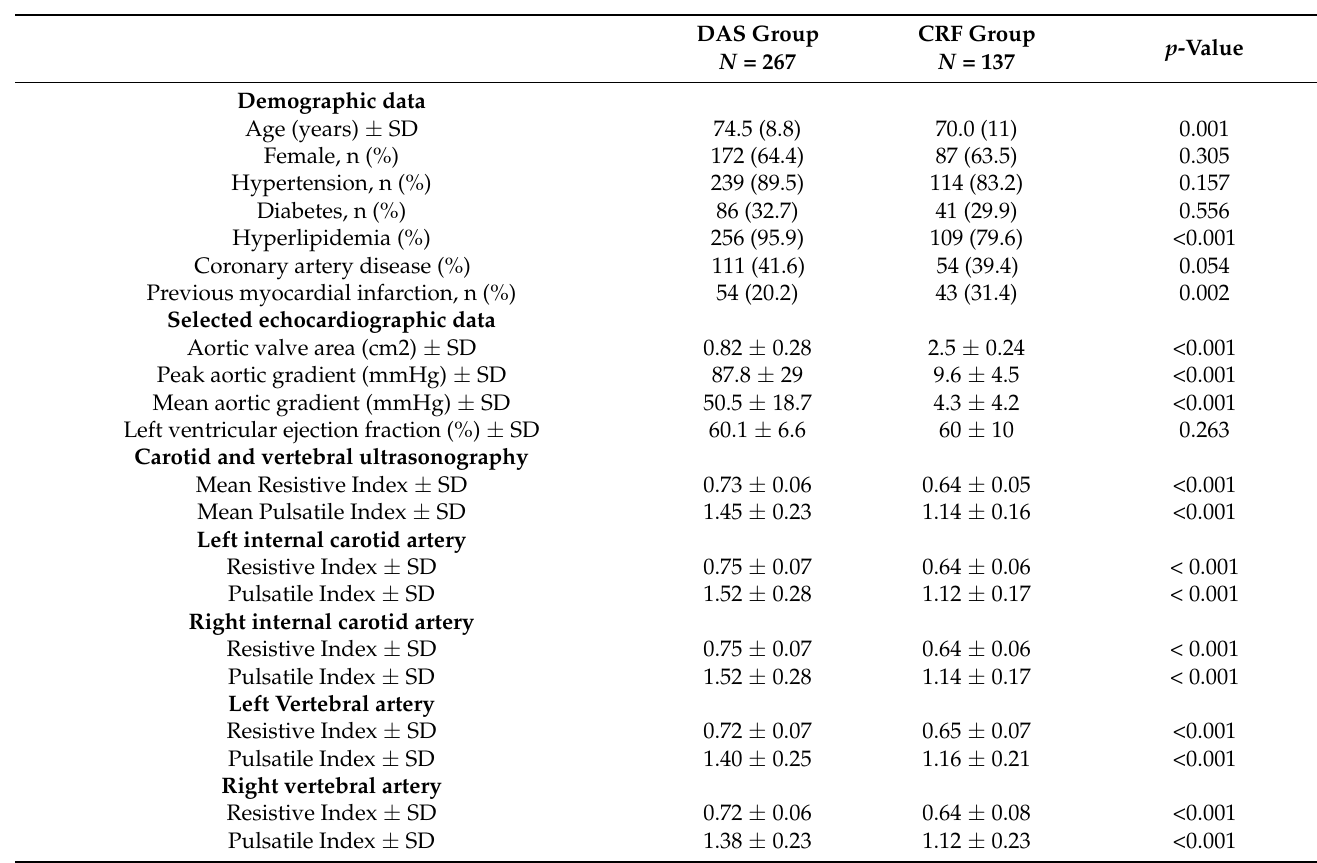
Table 1. Baseline groups